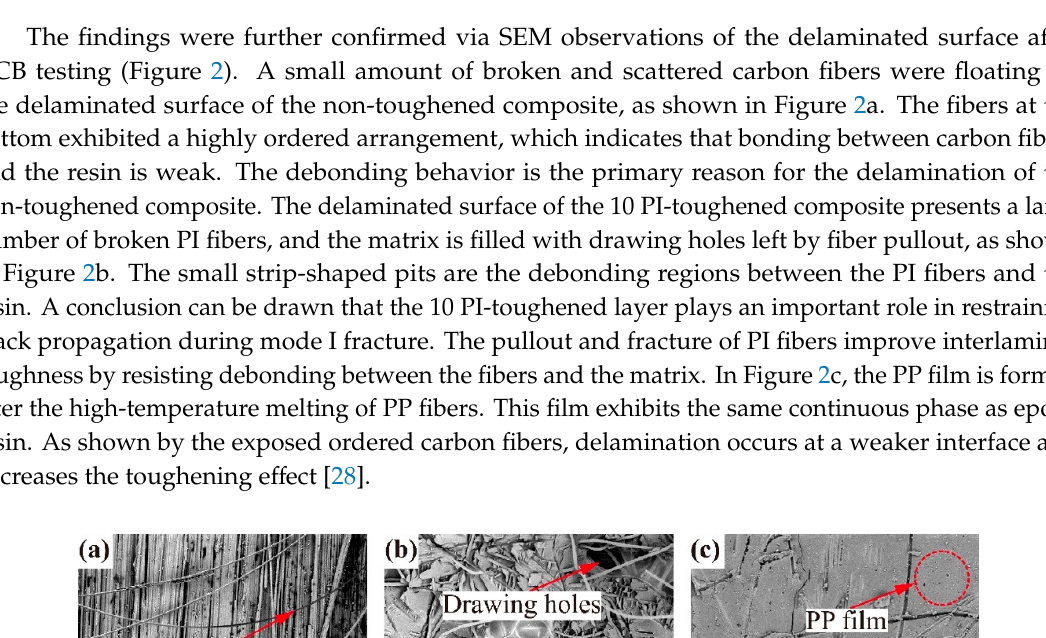
Figure 1. Load–displacement curves and Mode I interlaminar fracture toughness for the non-toughened, 10 PI- and 10 PP- toughened composites.